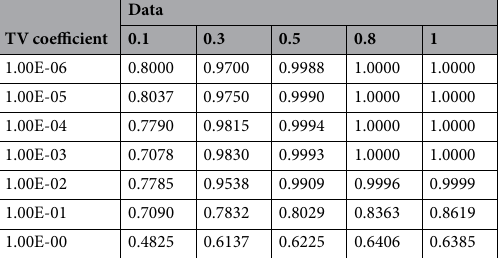
Table 4. Sensitivity analysis of TV penalty coefficient γ in Equation